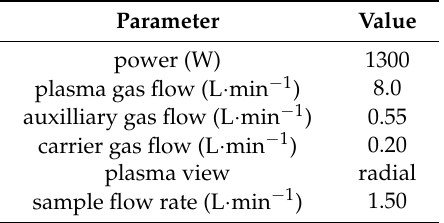
Table 3. Working conditions of the ICP-OES